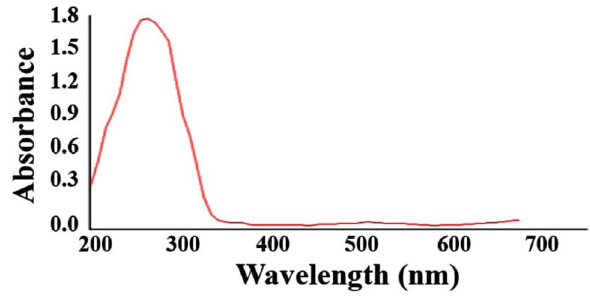
Figure 1. UV-spectroscopy of